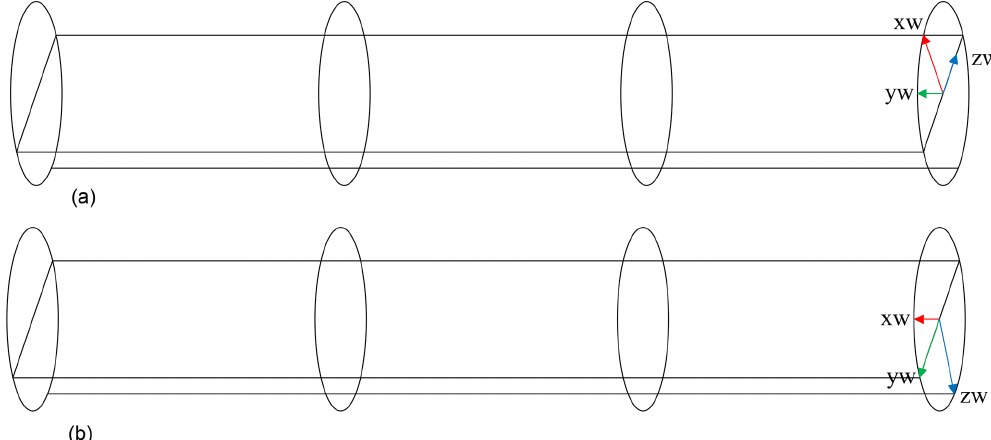
Figure 5. (a) The work plane in the XZ direction. (b) The work plane in the ZY direction.